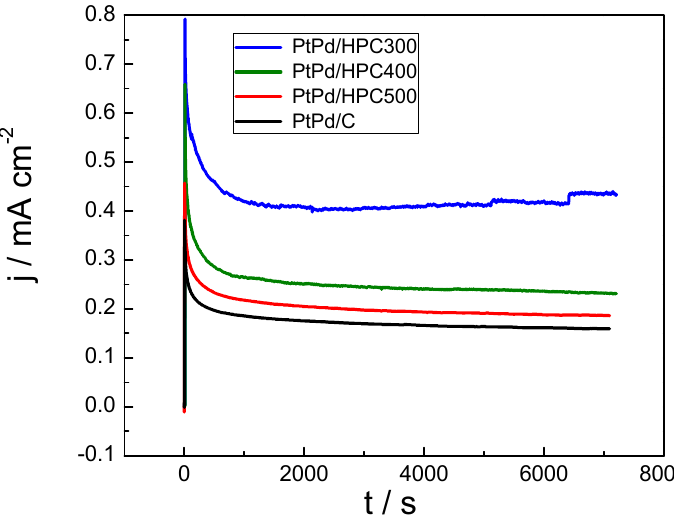
Figure 5. Chronoamperometric curves in terms of current densities for PtPd/HPC300, PtPd/HPC400, PtPd/HPC500 and commercial catalyst recorded at 0.55 V SO , 25 °C. HCOOH + 0.5 M H 2 4